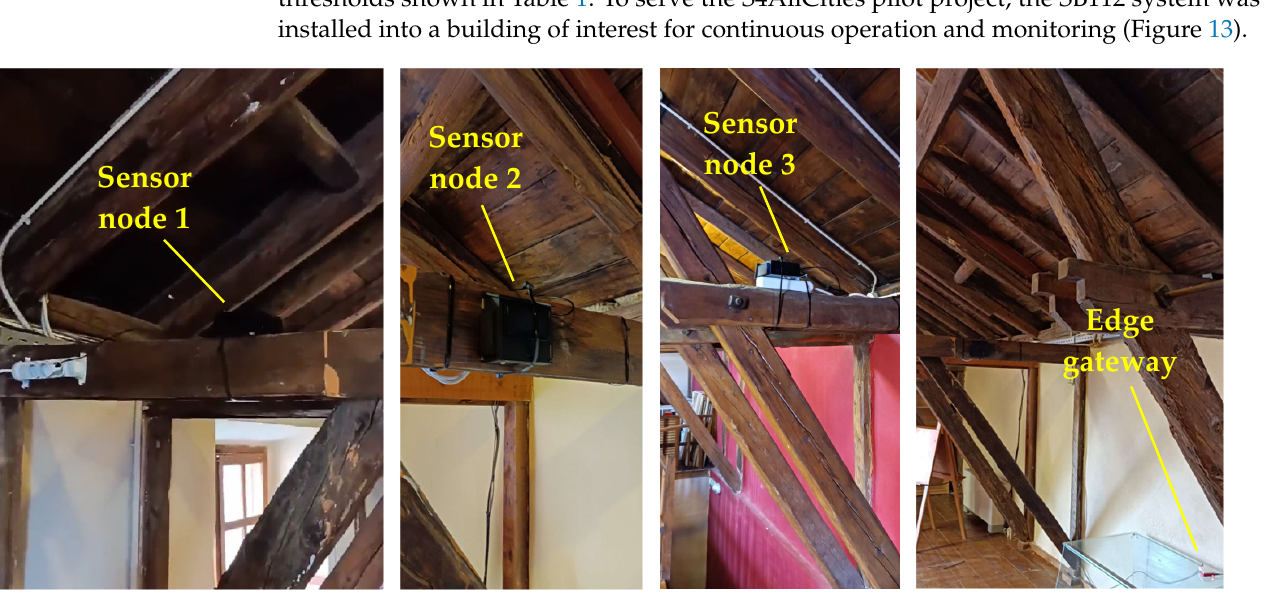
Figure 12. CAP message associated with the NG112 emergency call that the PSAP operator receives.